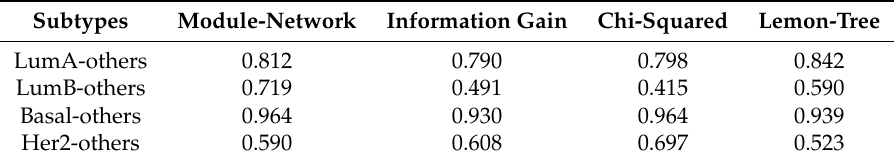
Table 3. The F-measure of 10-fold cross validation between